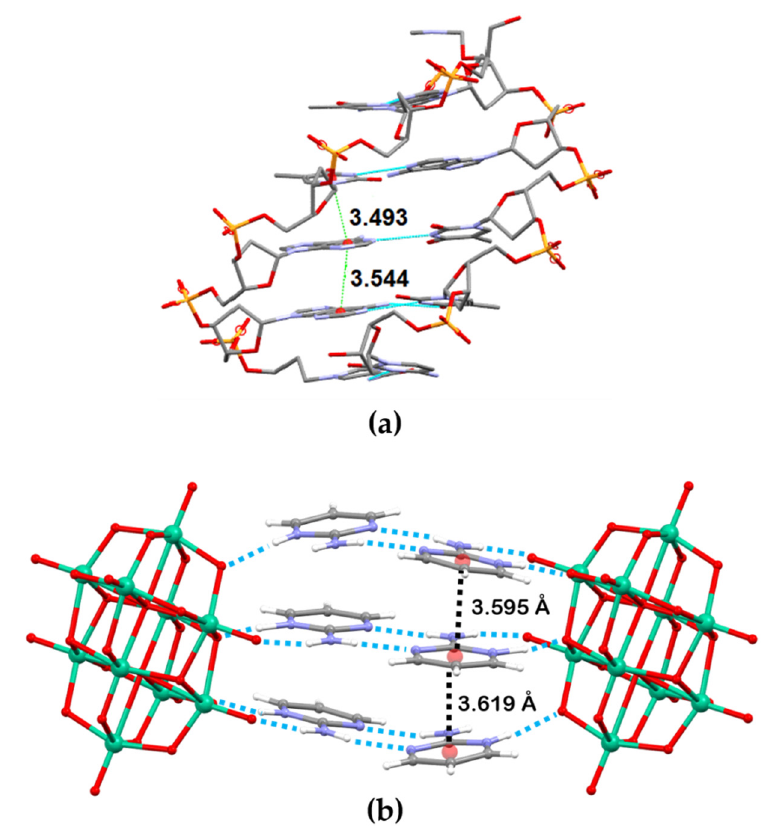
Figure 4. ( a ) Small fragment of DNA (1BNA) and ( b ) Compound 1 show a similar structure, with distances between centroids in the same range. Vanadium atoms are represented in green.